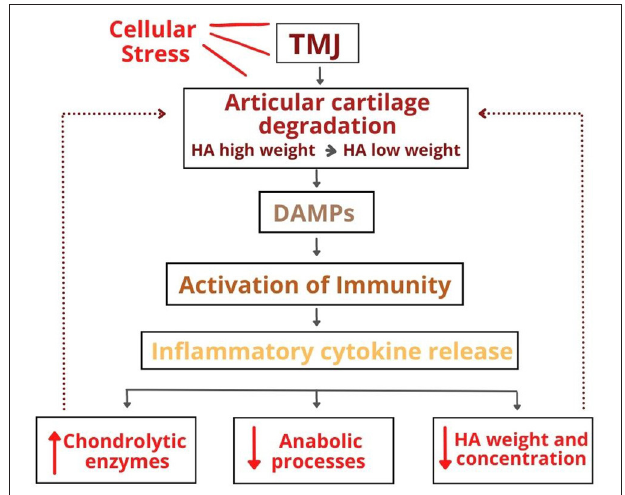
FIGURE 1 | The role of hyaluronic acid in the etiopathogenesis of temporomandibular